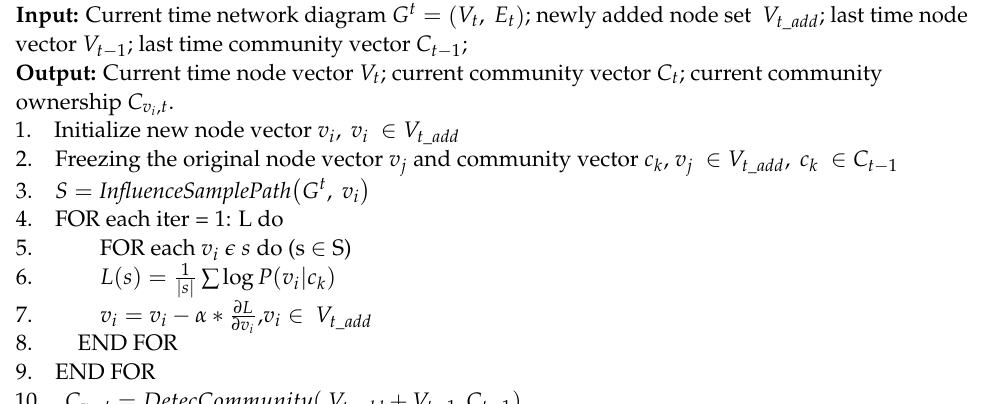
Algorithm 1 Dynamic community detection when new nodes are added and the number of communities remains unchanged